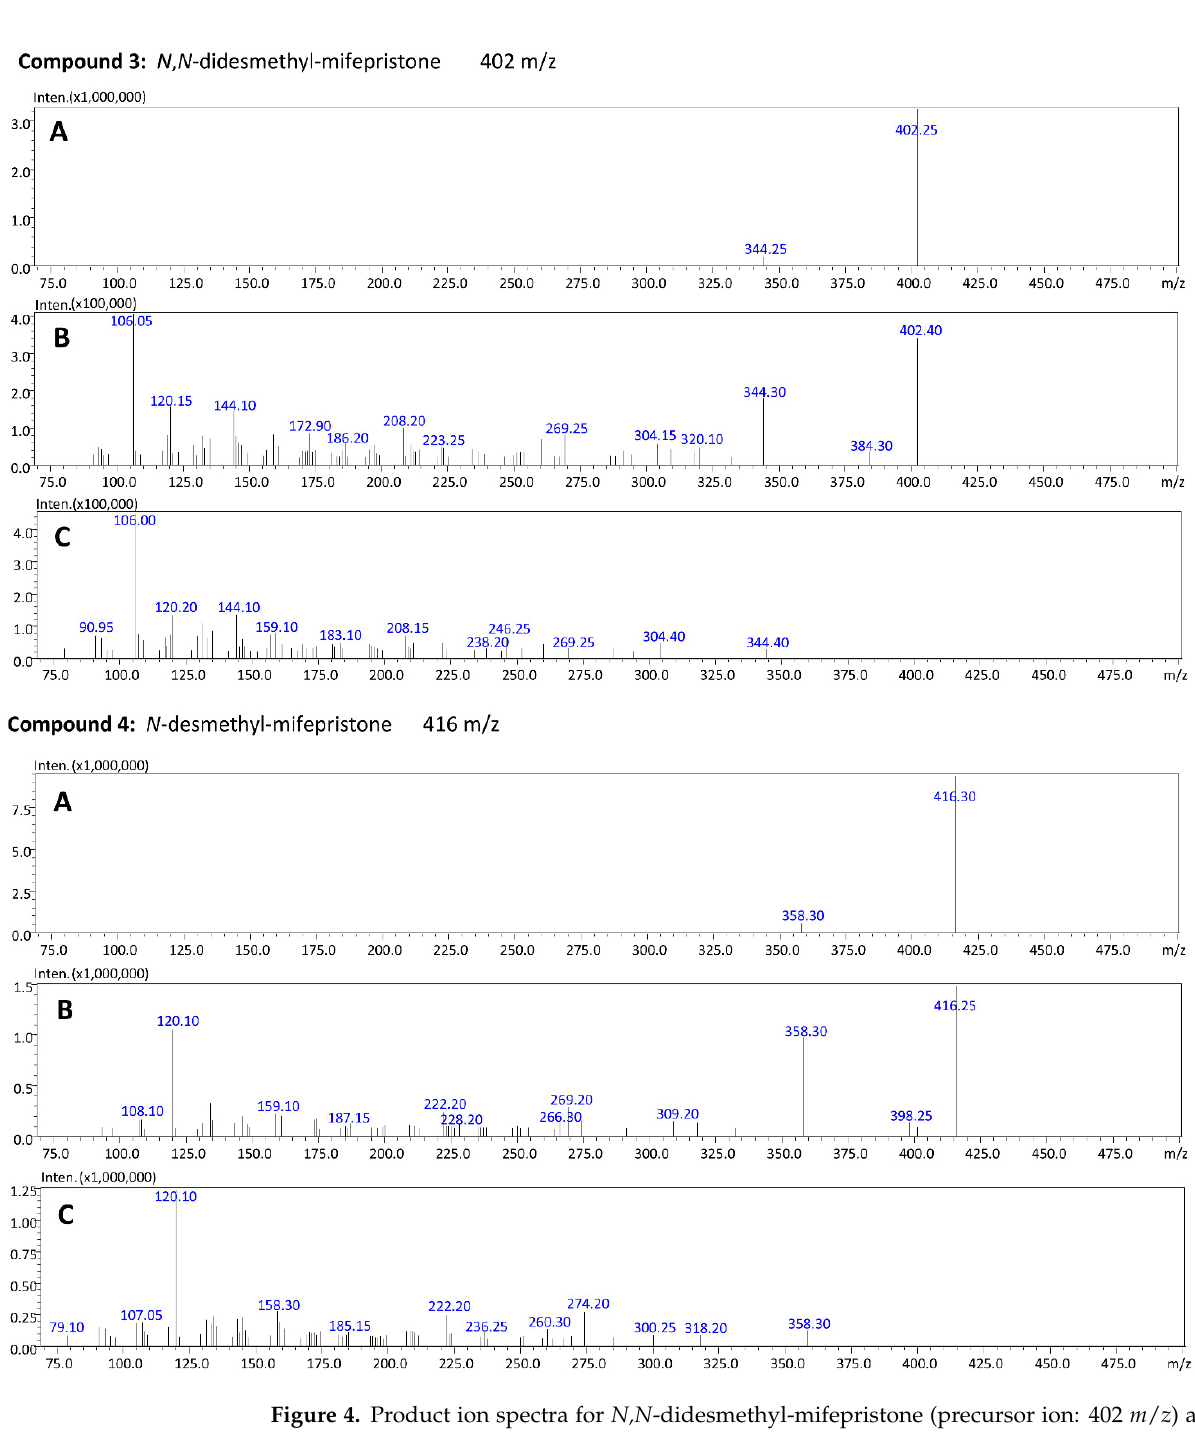
Figure 4. Product ion spectra for N,N -didesmethyl-mifepristone (precursor ion: 402 m / z ) and N - desmethyl-mifepristone (precursor ion: 416 m / z ) at three collision energies ( A ) − 10 V; ( B ) − 20 V and ( C ) − 35 V.